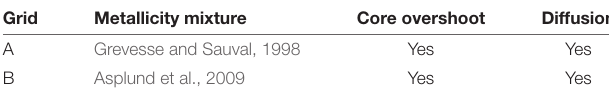
TABLE 1 | Main features of the model grids adopted in this